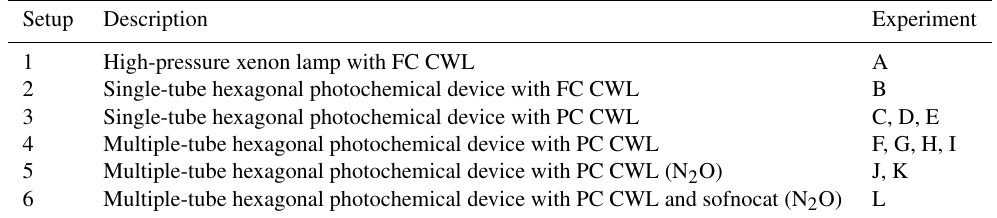
Table D4. Table summarizing experiments and setups. FC: flow-controlled, PC: pressure-controlled, CWL: chlorine waste line.